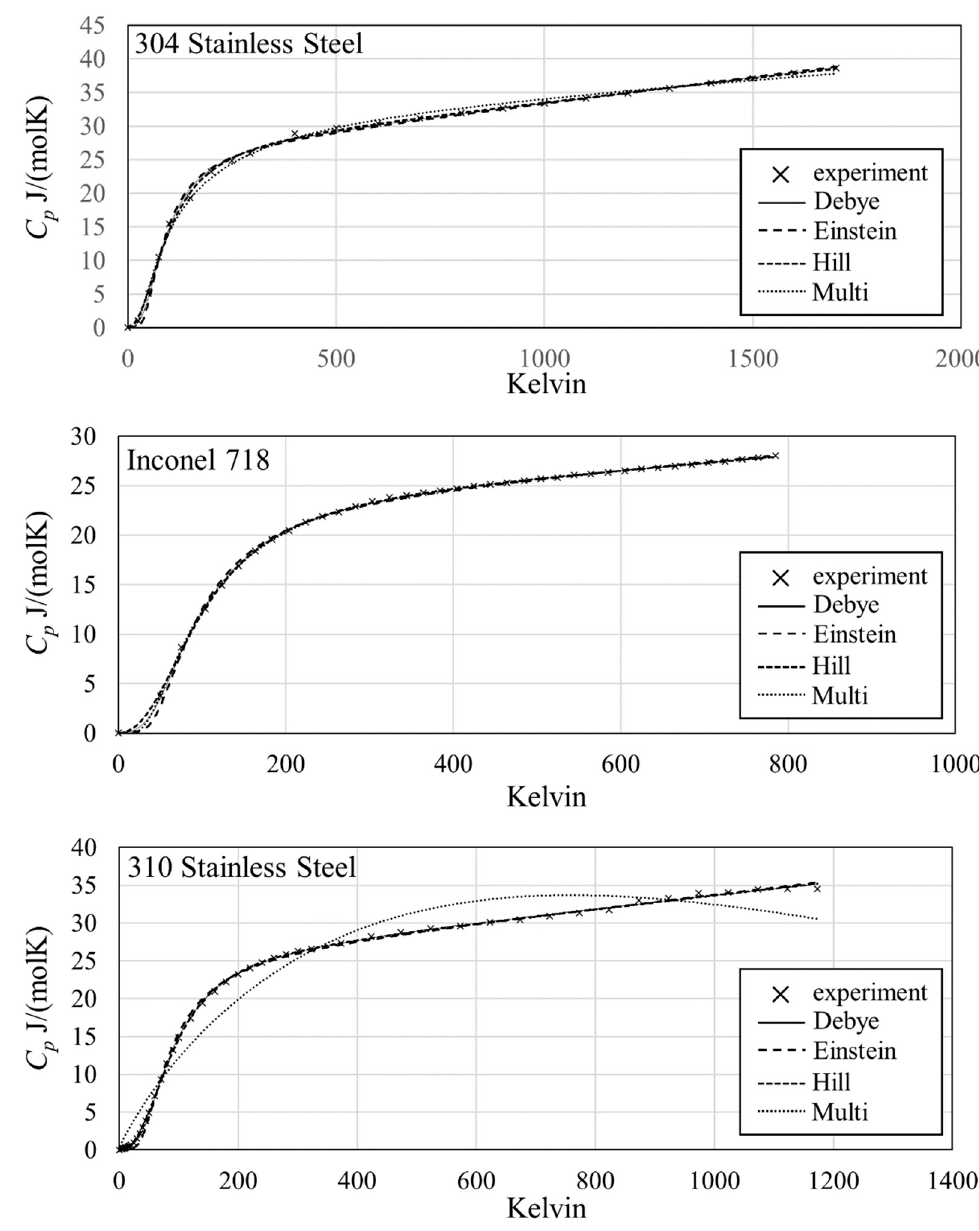
Figure 3. Model predictions for the specific heat of example metal alloys. Prior work has shown a correlation between the Hill coefficient and Gibbs free energy of interaction in noncovalent binding [23]. Under Richard’s Rule, the standard enthalpy of fusion underpins Gibb’s free energy in covalent solid binding [18]. A correlation between the enthalpy of fusion and the Hill Coefficient could imply a fundamental basis for use of the Hill Equation in solid specific heat estimation. To explore this possibility, the discovered Hill Coefficients were plotted against the enthalpy of fusion for alkaline metals and alkaline halides. Figure 6 shows the results. A linear trend was observed within the alkaline metals and alkaline halide groups on the periodic table, although not across alkaline metals and alkaline halides